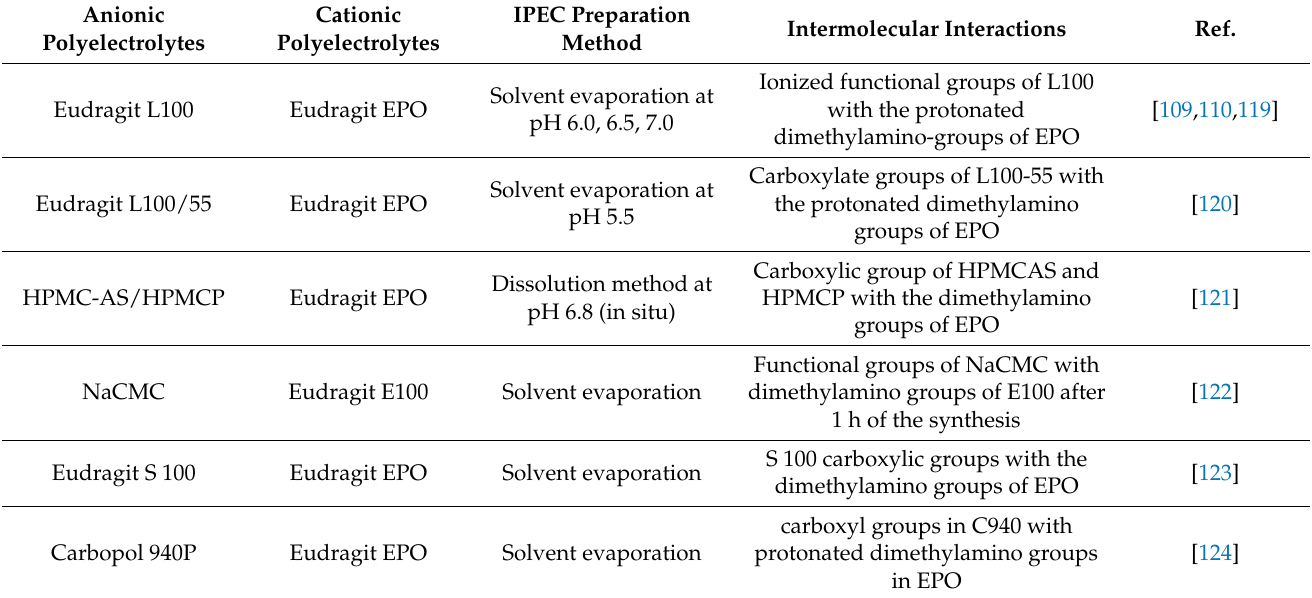
Table 3. List of reported IPECs and the intermolecular interactions in their